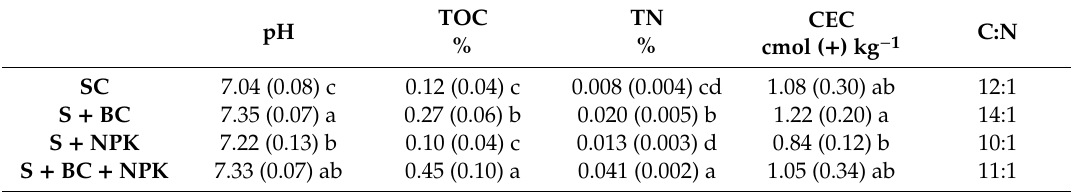
Table 2. E ff ect of biochar and fertilizer on basic substrate properties: Letters indicate significant di ff erences among the treatments ( p = 0.05). SD values are given in brackets.